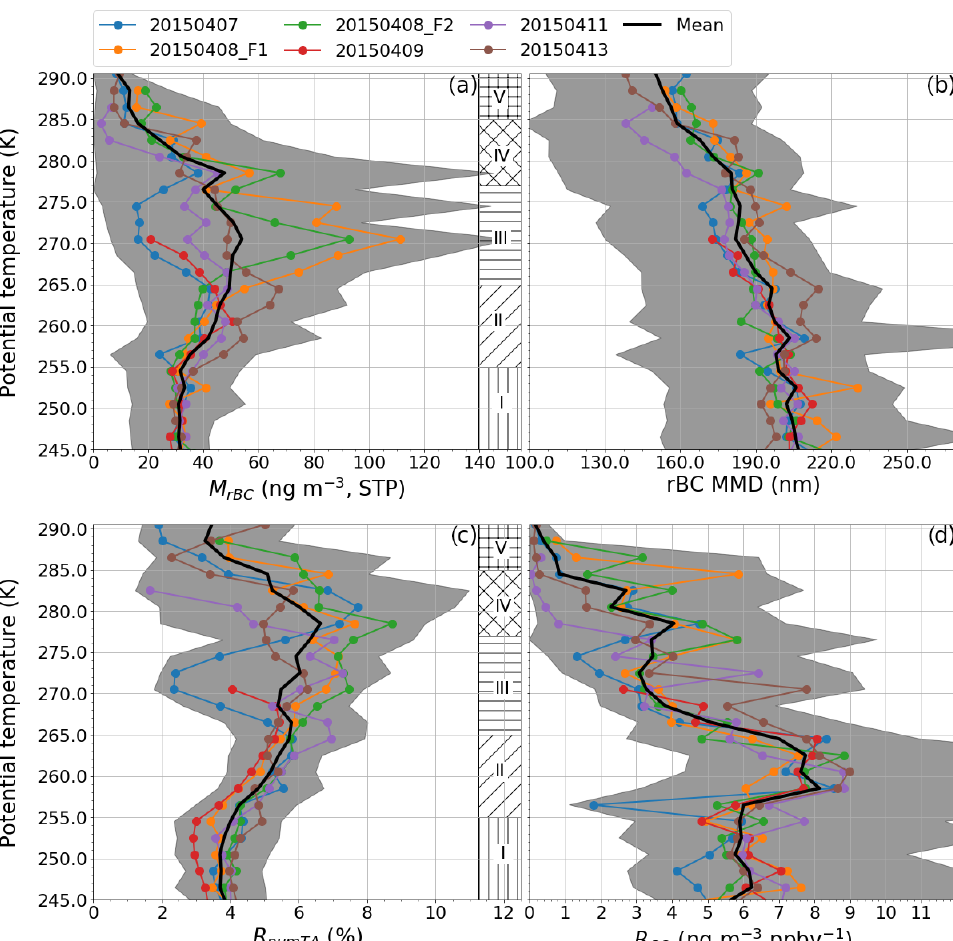
Figure 5. Flight profiles averaged over intervals of potential temperature from the spring polar dome of (a) M rBC , (b) MMD, (c) R numTA and (d) R CO . The grey shading around the mean over all profiles (black line) indicates the minimum 25th and maximum 75th percentiles of the flight profiles included in the mean. Five levels with different variability patterns as discussed in the text are marked with hatch